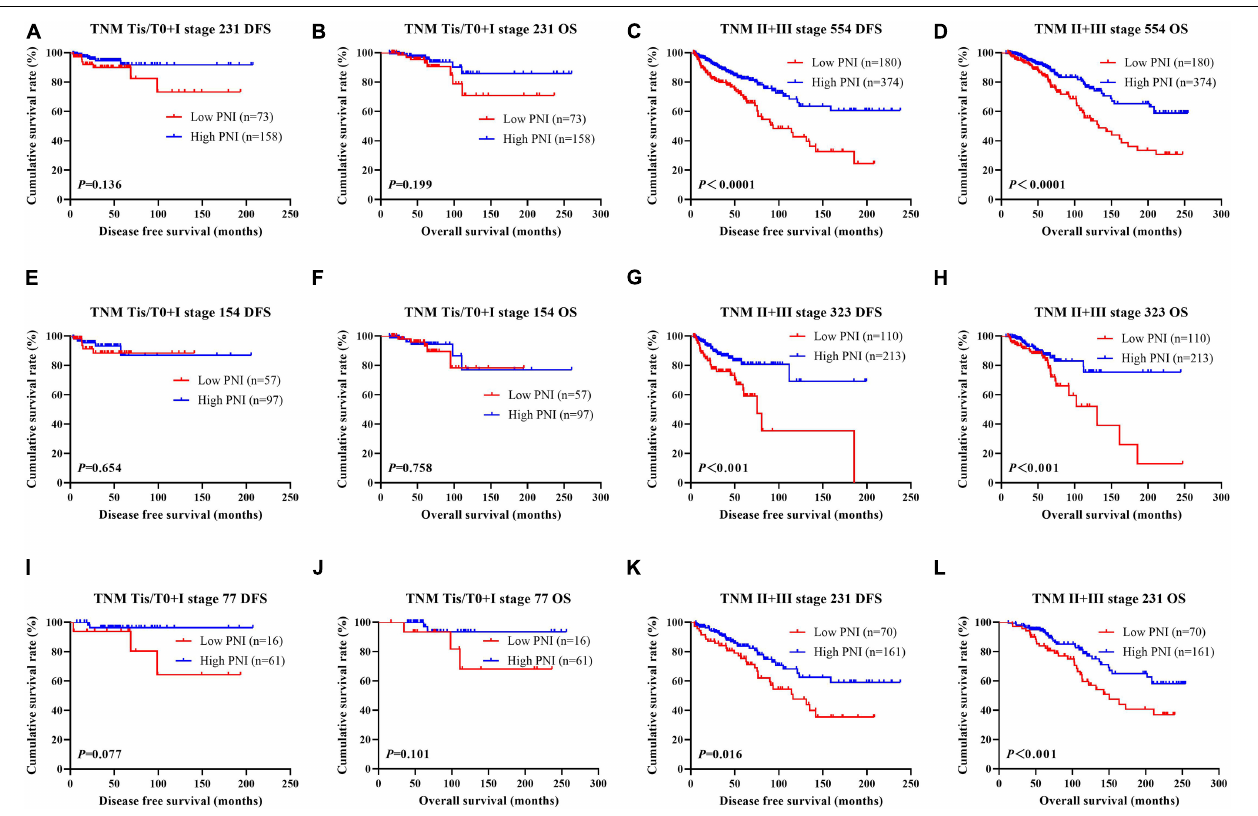
FIGURE 2 | Disease-free survival (DFS) and overall survival (OS) for the prognostic nutritional index (PNI) of patients with breast cancer in different pathologic stages. (A,B) Kaplan–Meier analysis of DFS (A) and OS (B) for the PNI of patients with early stage breast cancer (Tis/T0 + I stage) in all enrolled patients. (C,D) Kaplan–Meier analysis of DFS (C) and OS (D) for the PNI of patients with advanced stage breast cancer (II + III stage) in all enrolled patients. (E,F) Kaplan–Meier analysis of DFS (E) and OS (F) for the PNI of patients with early stage breast cancer (Tis/T0 + I stage) in the neoadjuvant chemotherapy (NACT) group. (G,H) Kaplan–Meier analysis of DFS (G) and OS (H) for the PNI of patients with advanced stage breast cancer (II + III stage) in the NACT group. (I,J) Kaplan–Meier analysis of DFS (I) and OS (J) for the PNI of patients with early stage breast cancer (Tis/T0 + I stage) in the non-NACT group. (K,L) Kaplan–Meier analysis of DFS (K) and OS (L) for the PNI of patients with advanced stage breast cancer (II + III stage) in the non-NACT